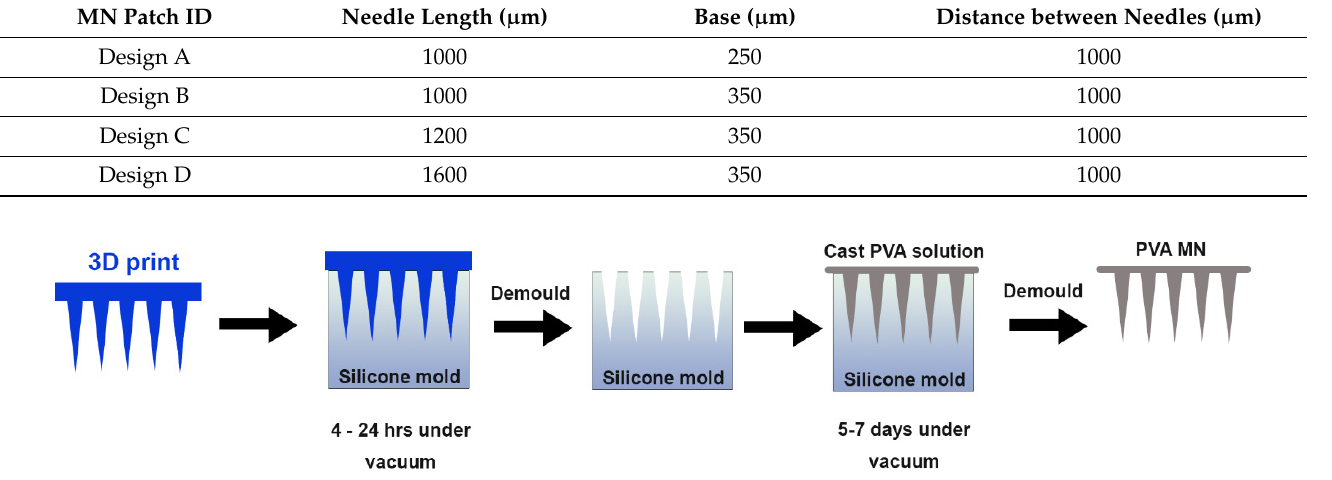
Figure 2. Fabrication method for PVA microneedle patches. A 3D print (blue) is used to cast the negative mold in silicone. In the final step, PVA (gray) is pipetted into the silicone mold and dried under vacuum for up to a week.